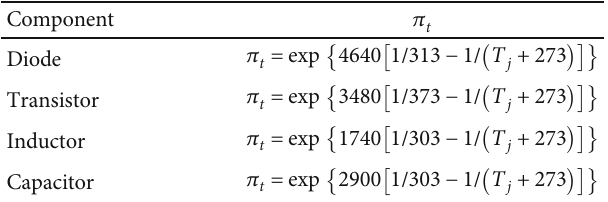
Table 5: Arrhenius model.